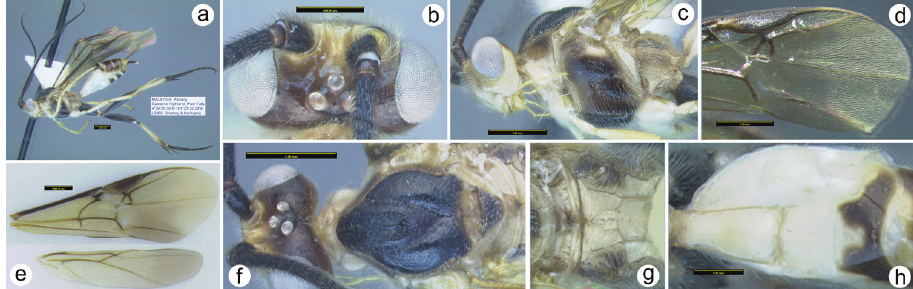
Figure 11. Zelodia pahangensis sp.n. a lateral habitus b dorsal head c lateral head and mesosoma d apex of fore wing e wings f dorsal head and mesosoma g dorsal propodeum h dorsal